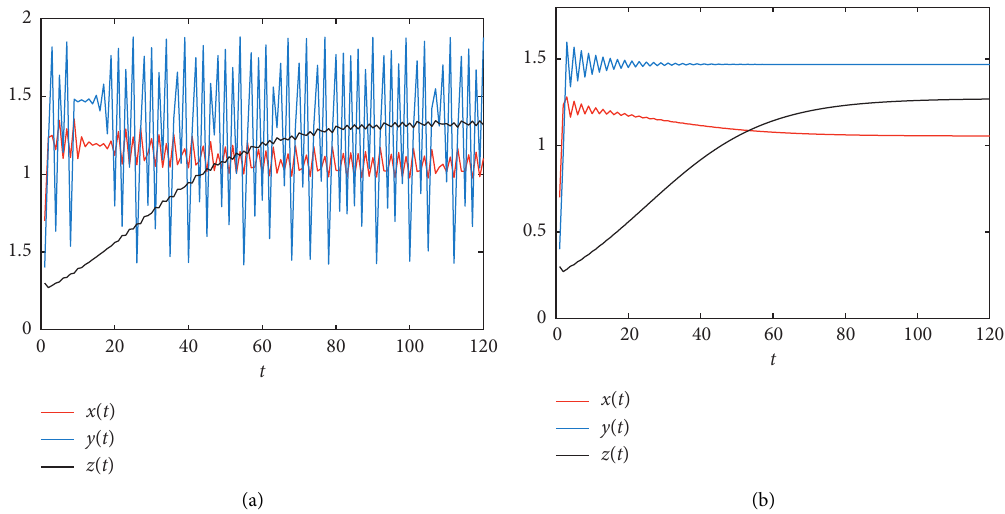
Figure 20: Effects of control factor k on x ( t ), y ( t ), and z ( t ): (a) k � 0; (b) k �